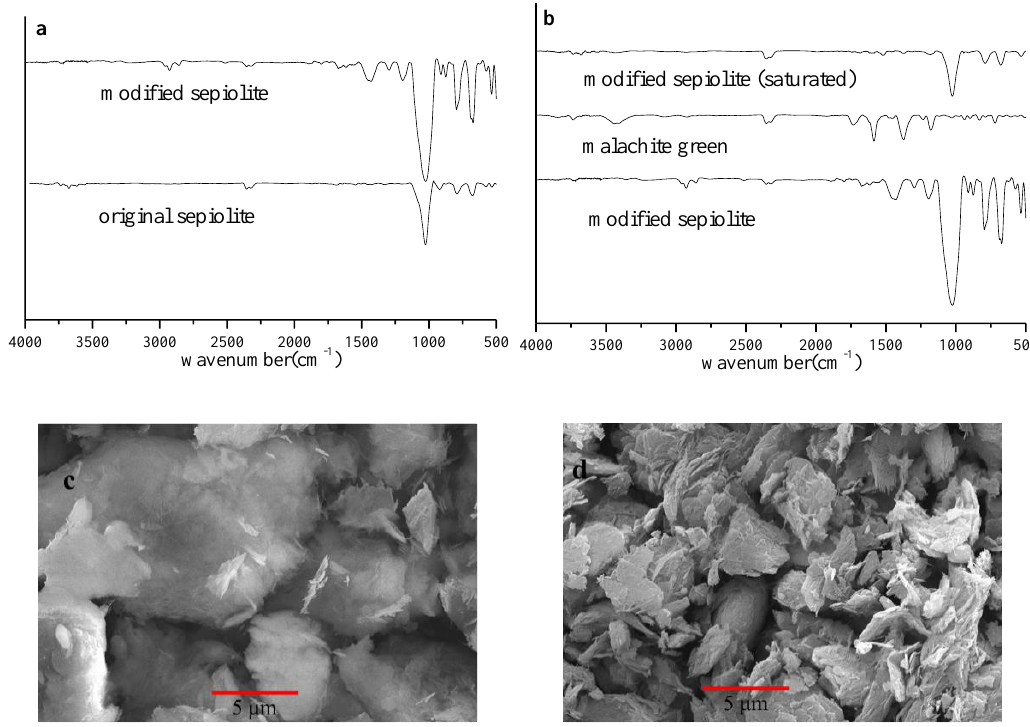
Figure 4. FTIR spectrum of original sepiolite, modified sepiolite, malachite green and modified sepiolite after adsorption saturation, ( a ) and ( b ). SEM images of original sepiolite ( c ) and modified sepiolite ( d ).